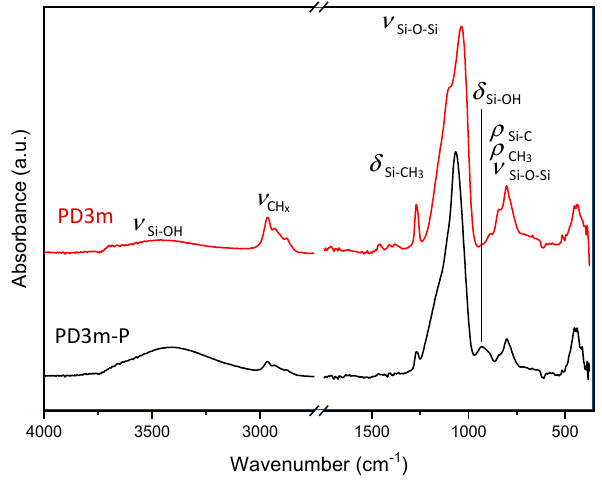
Figure 3. FT-IR spectra of PD3m and PD3m-P coatings.